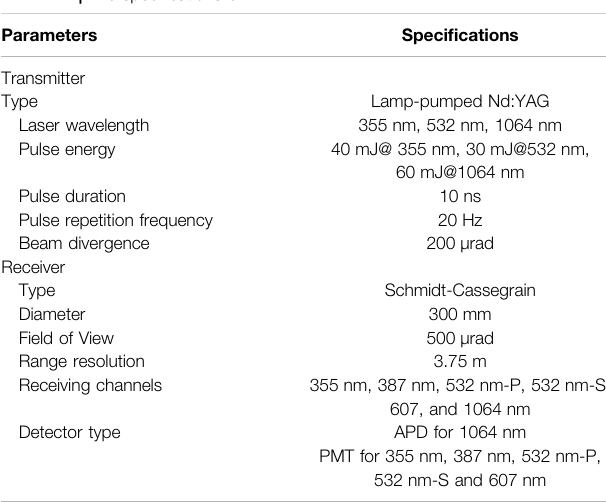
TABLE 1 | The speci fi cations of